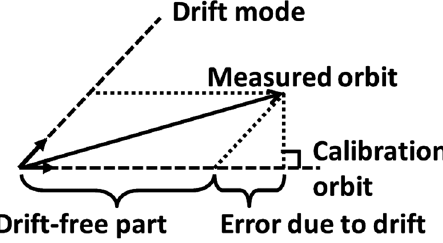
FIG. 8. Drift-mode removal of measured